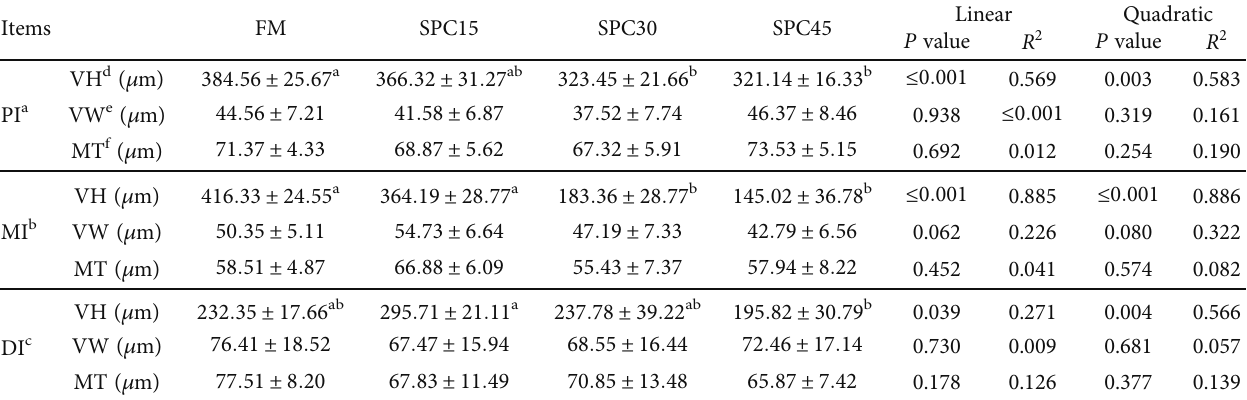
Figure 2: The liver health related gene expression levels in the liver of large yellow croaker fed the experimental diets. Akp : alkaline phosphatase; acp : acid phosphatase; alt : alanine aminotransferase; ast : aspartate aminotransferase. Table 5: The intestinal morphology of large yellow croakers fed the experimental